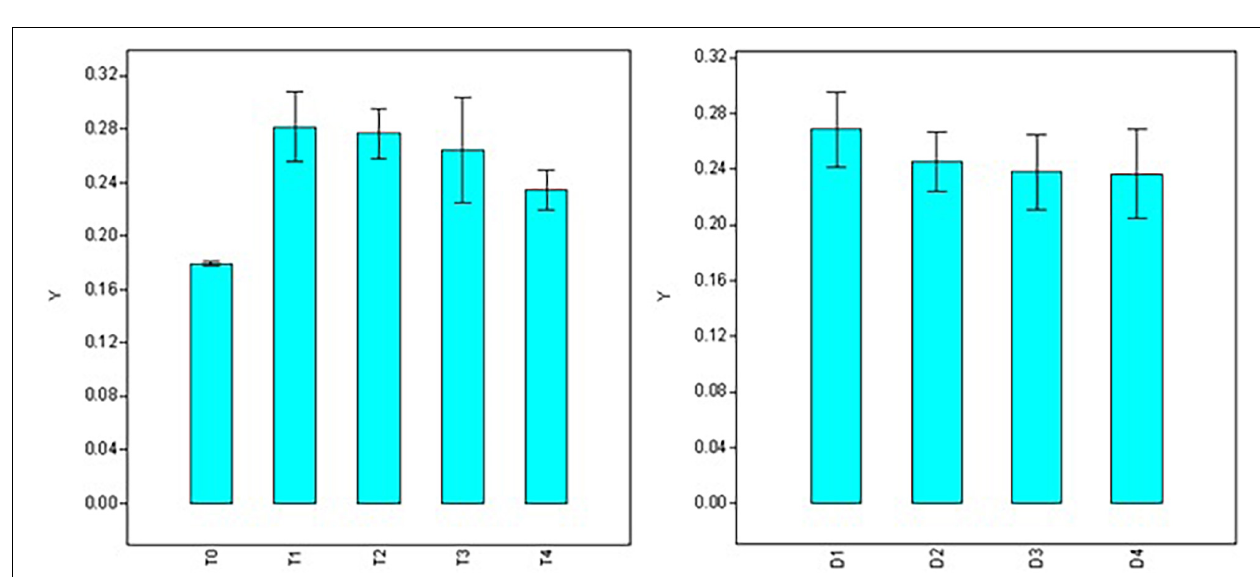
FIGURE 3 | Effect of NAA doses (left) and durations (right) on root length (cm) in apical shoots of Valeriana jatamansi .